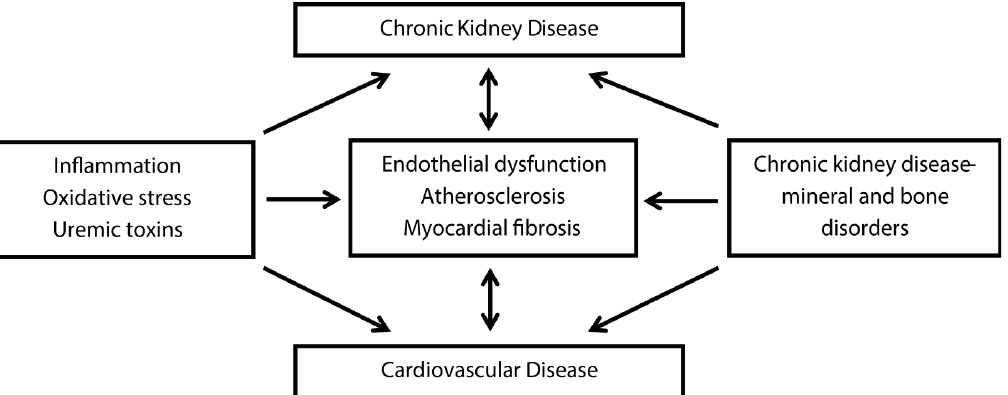
Figure 4. Cardiovascular disease in chronic kidney disease. This figure shows inflammation, oxidative stress, and uremic toxins on one side and chronic kidney disease-mineral and bone disorders on the other side of independent mechanisms linking chronic kidney and cardiovascular disease.